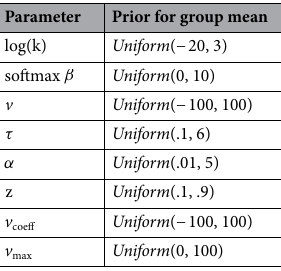
Table 1. Ranges for the uniform priors of group-level parameter means. Ranges were chosen to cover numerically plausible values. Parameters included in multiple models are only listed